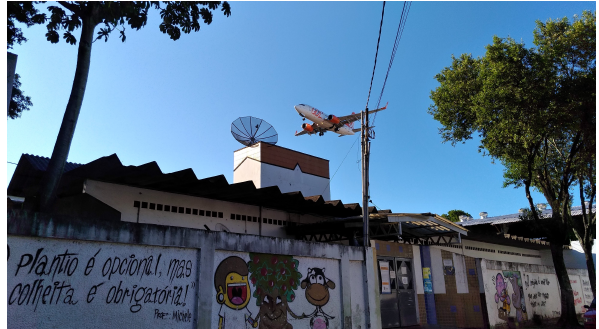
Figure 3: Main building facade.